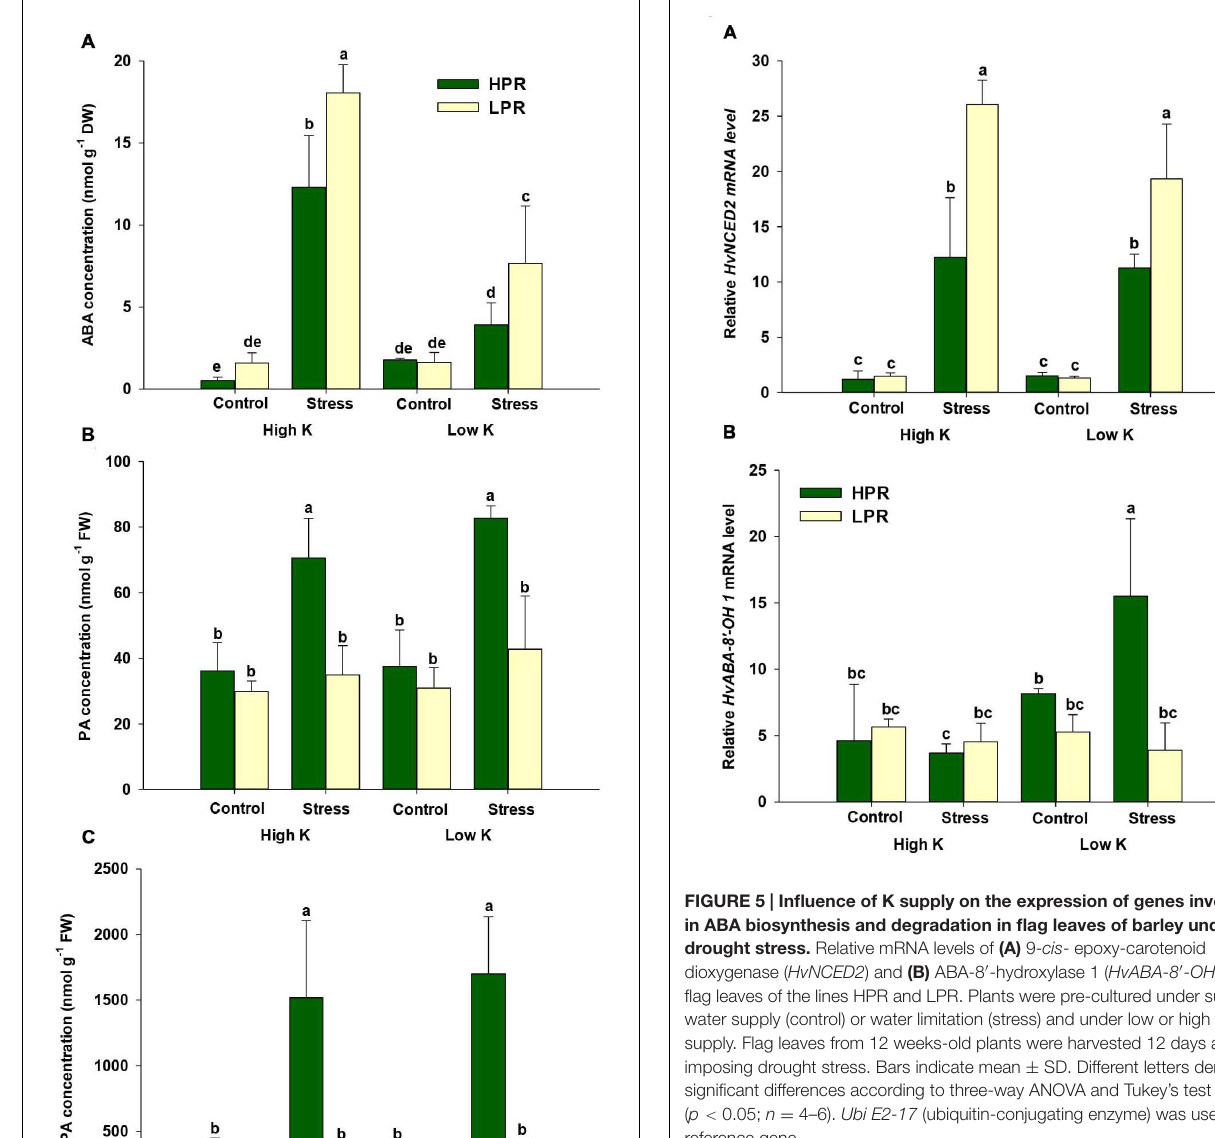
with the higher ABA levels in LPR ( Figure 4A ). On the other hand, monitoring ABA-8 (cid:48) -HYDROXYLASE 1 ( HvABA-8 (cid:48) -OH1 ),